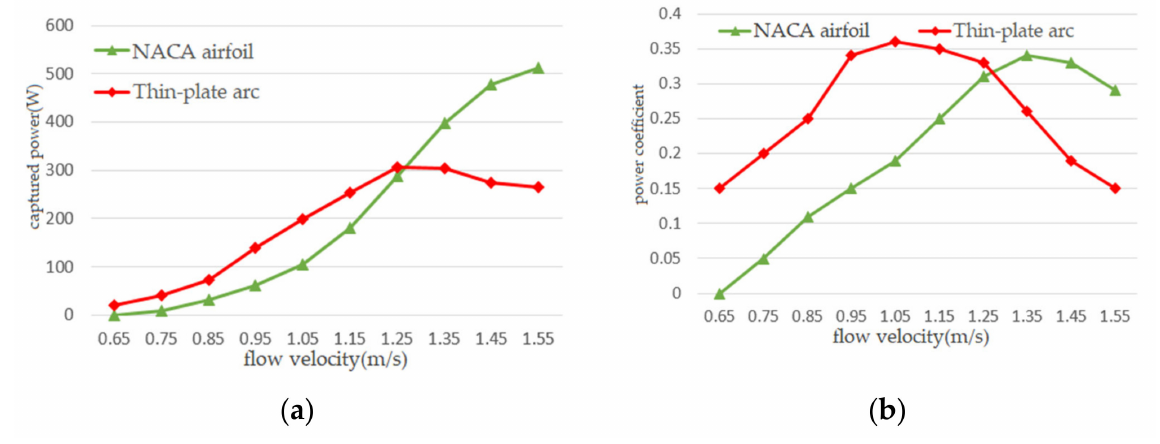
Figure 16. Performance of turbine at different velocities: ( a ) captured power; ( b ) power